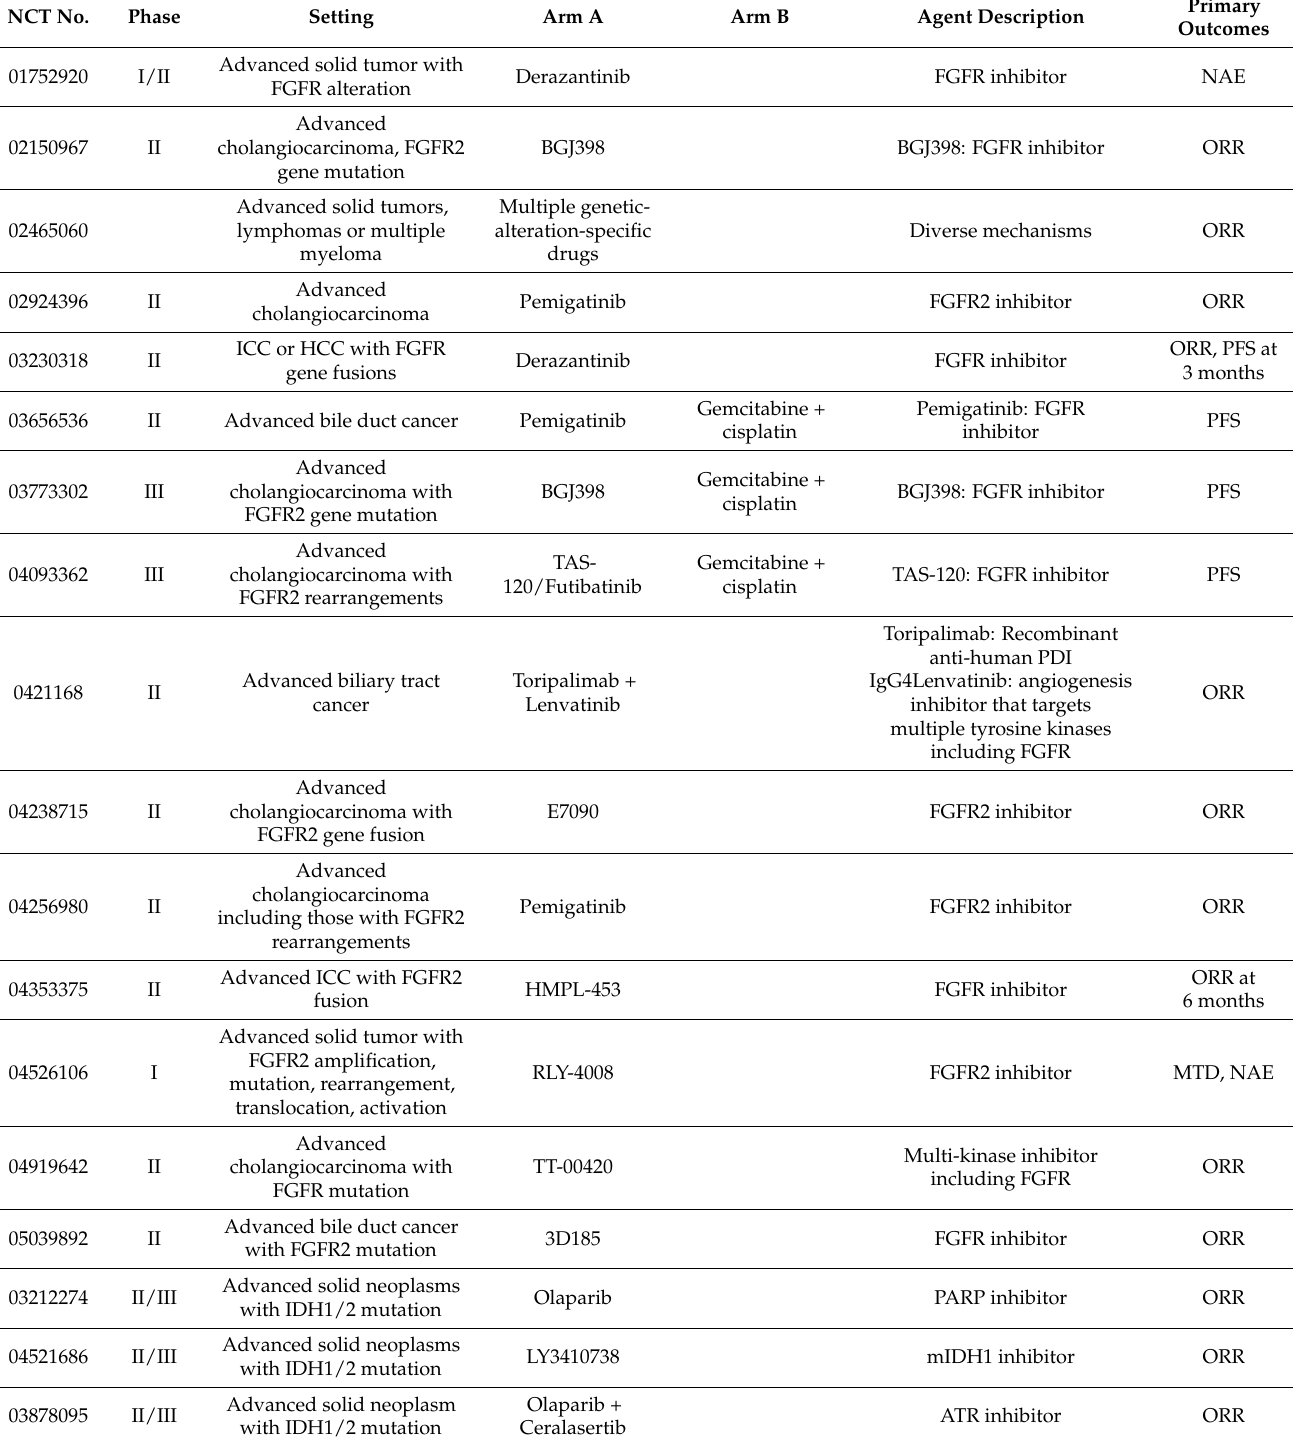
Ongoing trials evaluating FGFR and IDH1/2 inhibitors in patients with advanced solid tumors or ICC with or without known FGFR or IDH1/2 mutations, as listed on clinicaltrials.gov, accessed on 21 September 2021. HCC, hepatocellular carcinoma; ICC, intrahepatic cholangiocarcinoma; FGFR, fibroblast growth factor receptor; MTD, maximum tolerated dose; NAE number adverse events; ORR objective response rate; PFS, progression-free survival; PD1, programmed cell death